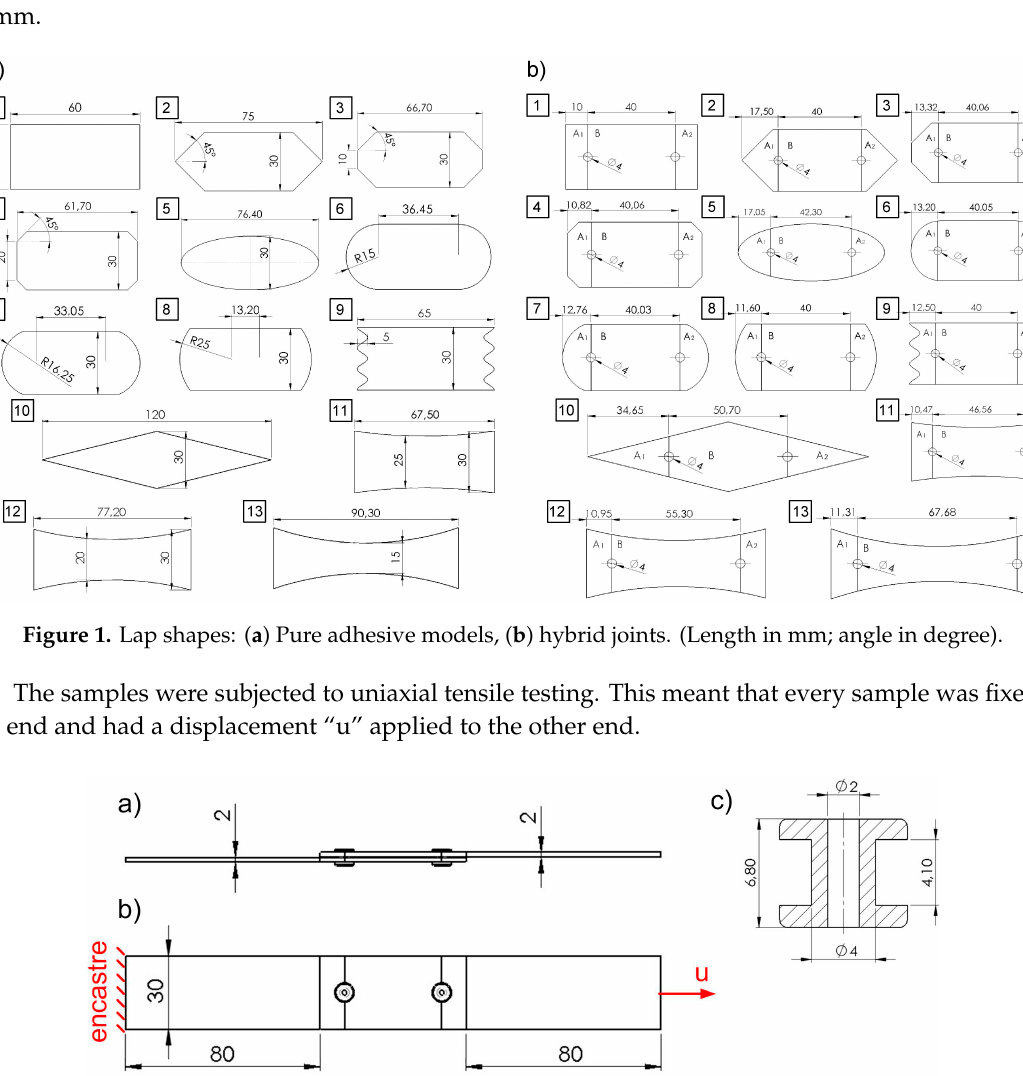
Figure 2. Main dimensions of the reference model (Model 1): ( a ) Side view, ( b ) boundary conditions, ( c ) rivet dimensions. (unit: mm)